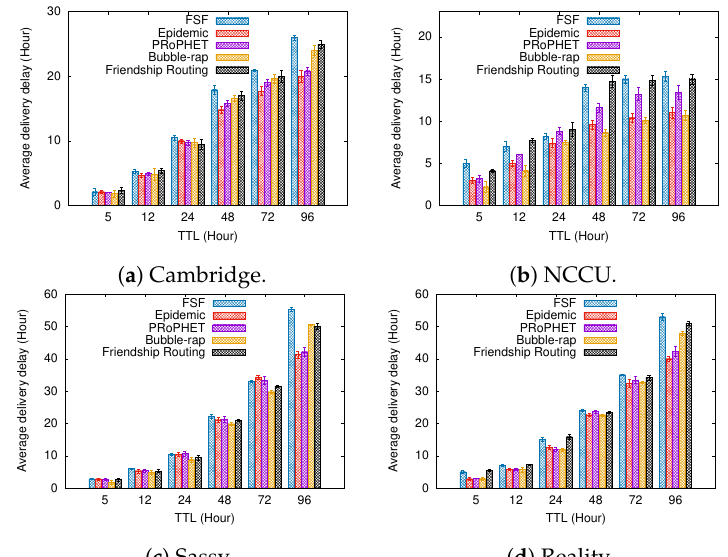
Figure 6. Average cost when increasing message TTL.